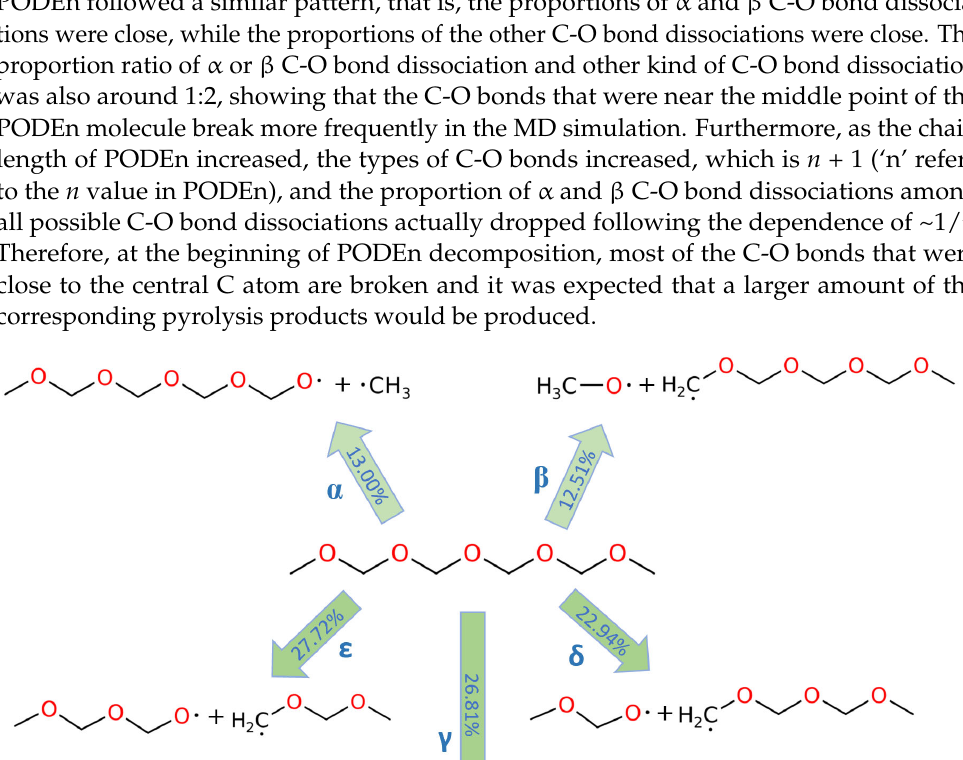
Figure 4. C ‐ O bond dissociation in PODE5 at 3000 K. 3.2. Bond Dissociation Energies of PODEn The bond dissociation energies (BDEs) of the C ‐ O bonds in PODEn were then calcu ‐ lated using the ReaxFF method to better understand the decomposition of PODEn. The results of BDEs of all aforementioned C ‐ O bonds in PODEn are shown in Table 1. As shown, the BDEs of α and β C ‐ O bonds were close, which were all around 70 kcal/mol, while the BDEs of the other kinds of C ‐ O bonds were close and all less than 65 kcal/mol, which were smaller than that of α and β C ‐ O bonds. This is consistent with the results in Section 3.1, indicating the intramolecular BDE is an important factor that affects bond dis ‐ sociation. Table 1. Bond dissociation energies of C ‐ O bonds in PODEn calculated using ReaxFF. C ‐ O Bond